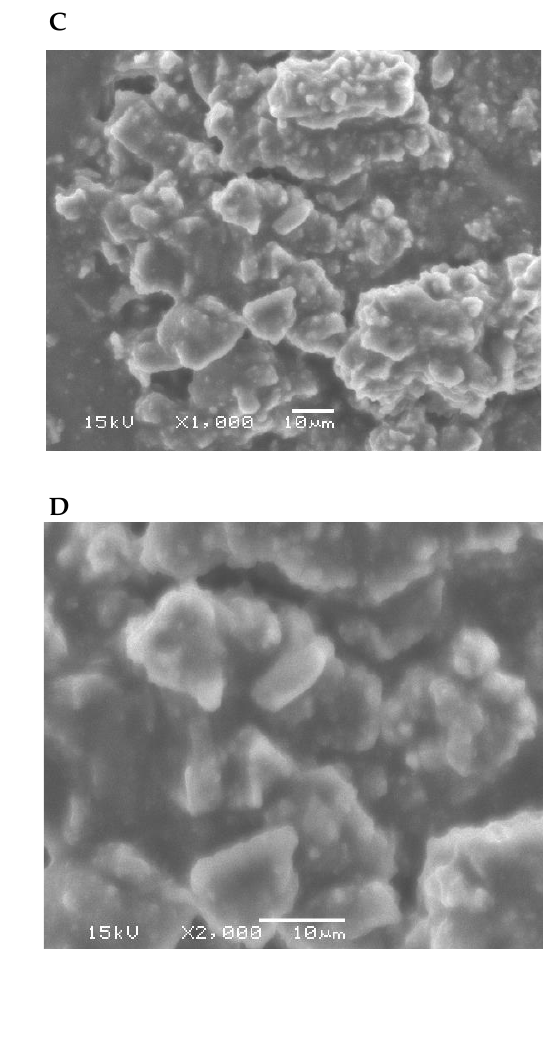
Figure 1. Physicochemical properties (size and polydispersity ( A ), zeta potential ( B ), and scanning electron microscope images of GnRH (Gonadorelin)-encapsulated chitosan–TPP nanoparticles at 1000 × ( C ) and 2000 × ( D